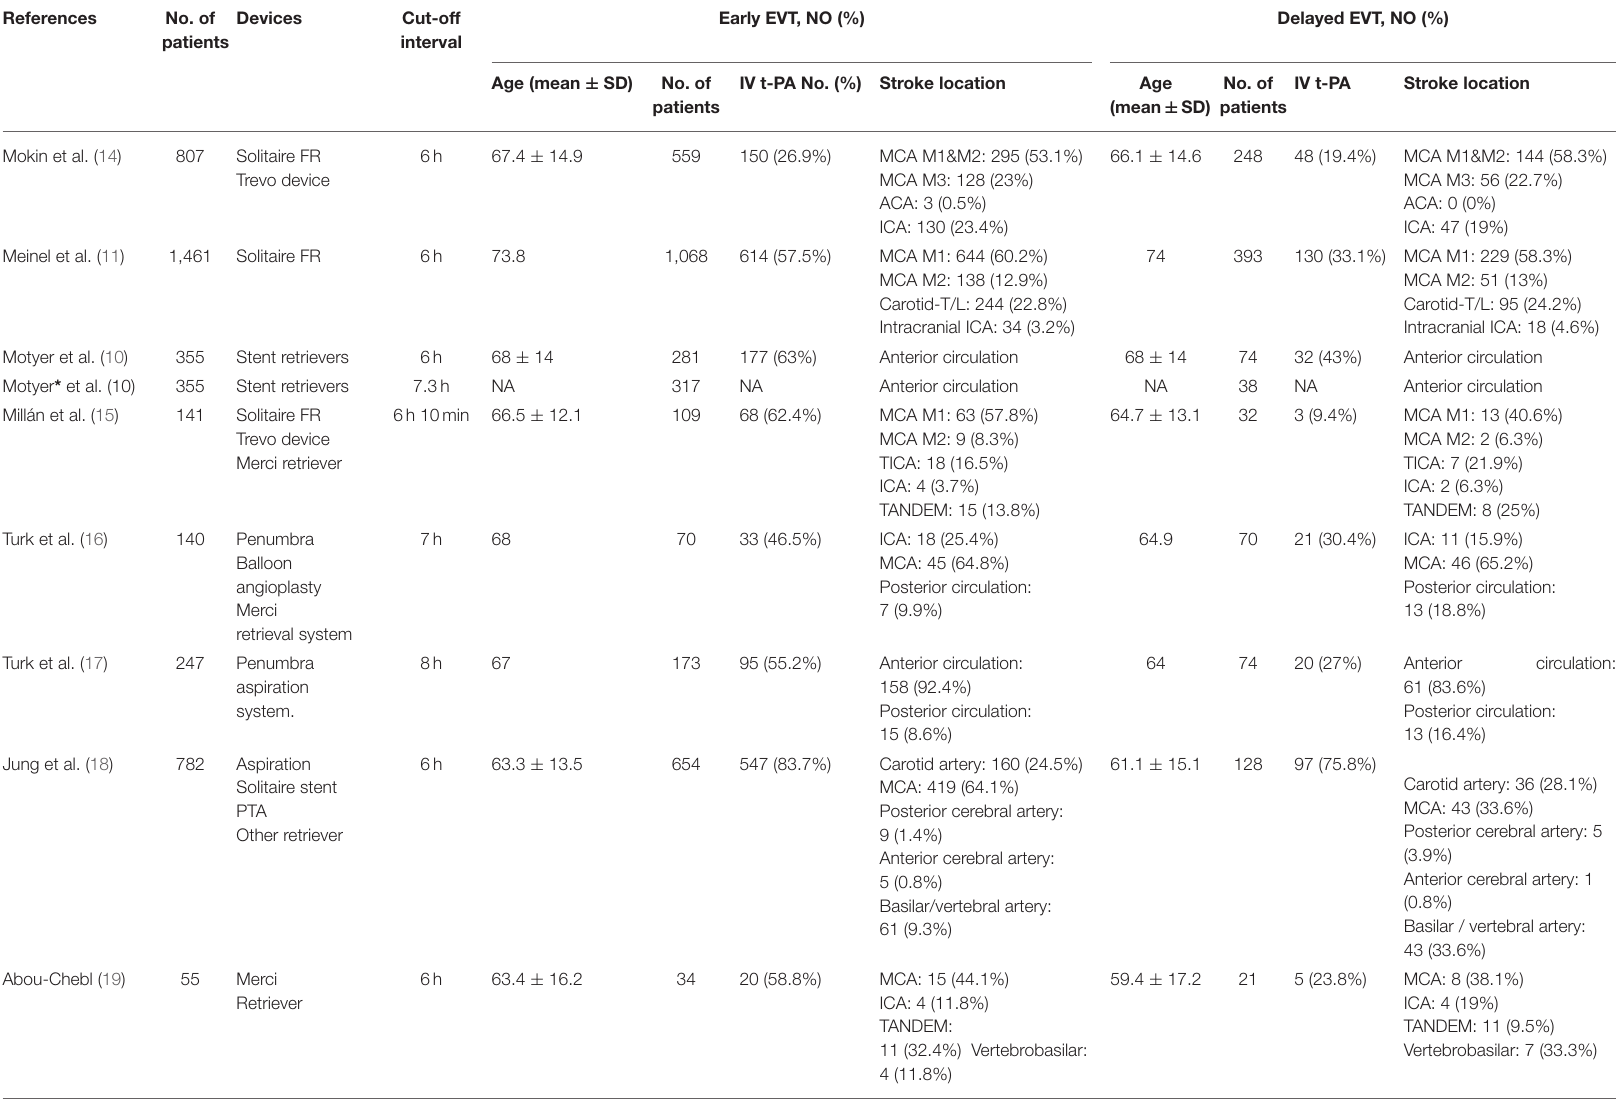
TABLE 1 | Characteristics of studies included in the